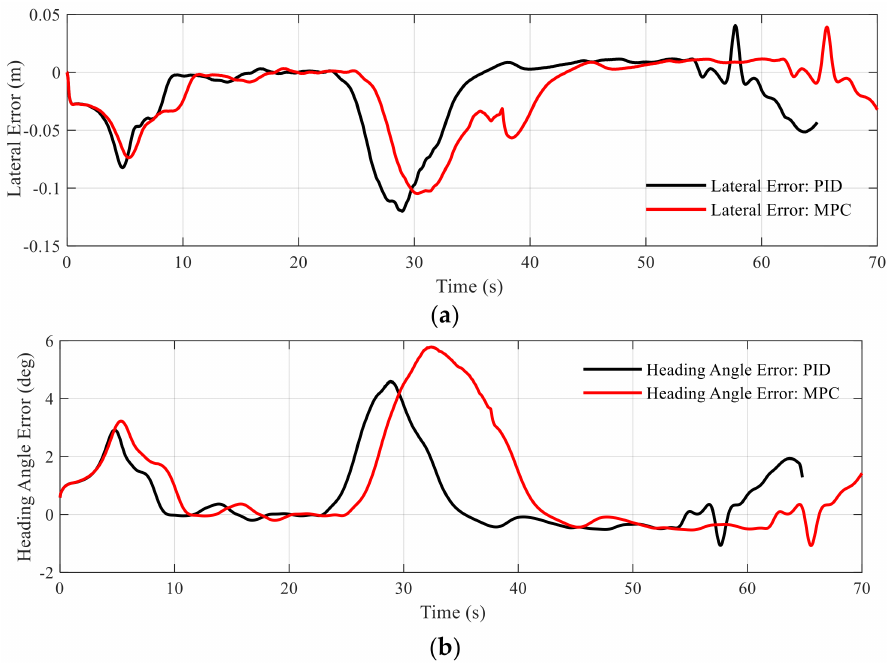
Figure 7. The lateral errors and heading angle errors comparison of two controllers, PID and MPC: ( a ) The lateral errors of two controllers; ( b ) The heading angle errors of two controllers. The comparison of the longitudinal and lateral acceleration during the path tracking of the autonomous vehicle is shown in Figure 8. As shown in Figure 8a, the longitudinal acceleration of the vehicle is always 0 in PID control, because only a single lateral tracking target is controlled in the path tracking. The lateral acceleration of PID control is shown by the black line in Figure 8b. The red line shows the longitudinal acceleration control based on the MPC in Figure 8a. To ensure that the vehicle can track stably, comfortably and safely, the path tracking of an autonomous vehicle under the MPC needs to combine the curvature of the reference trajectory and the vehicle stability constraints to control the longitudinal speed of the vehicle accordingly. Compared with the PID-based control, the average lateral acceleration of MPC drops from − 0.0606 to − 0.0376, the maximum acceleration fell from 0.4549 to 0.22 and the standard deviation decrease from 0.1194 to 0.0682.